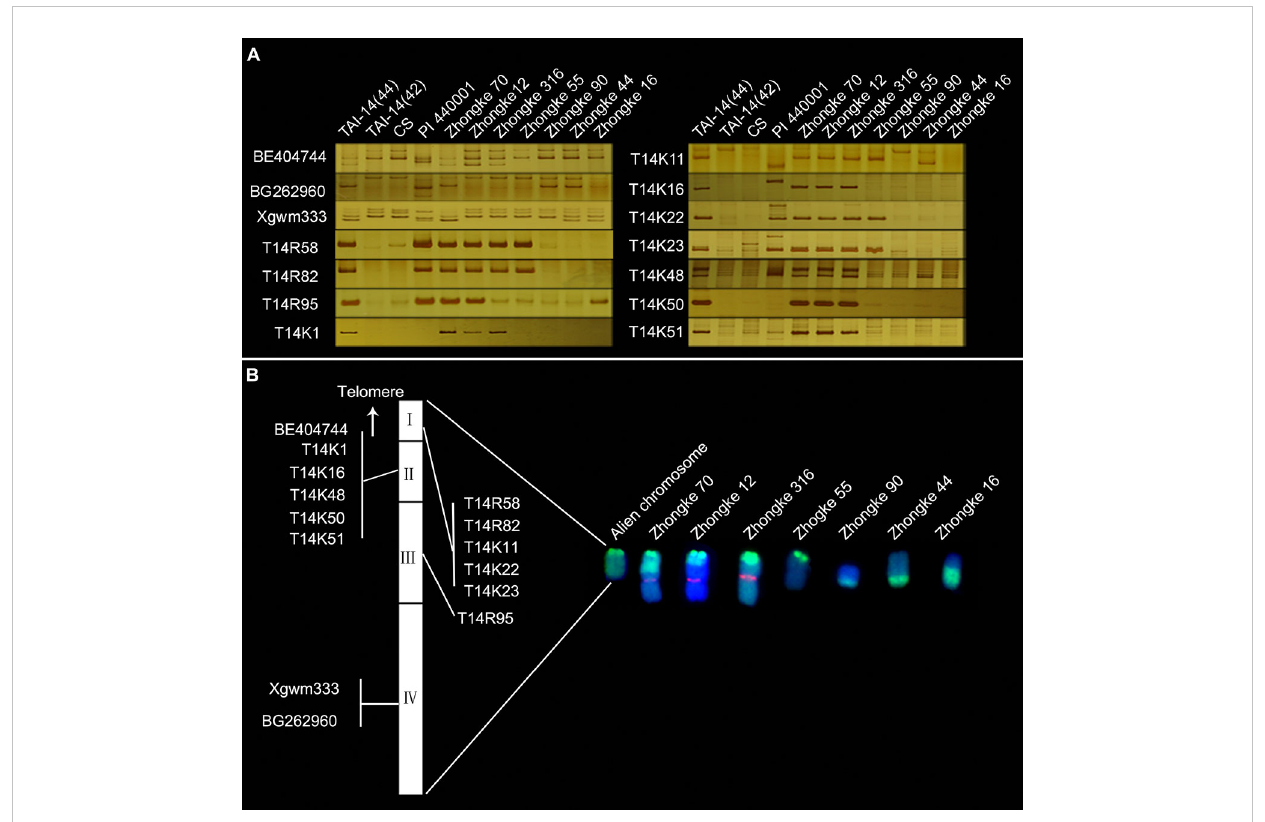
FIGURE 6 Speci fi c markers and a physical map for the alien chromosome. (A) Speci fi c markers for the alien chromosome and their distribution on seven translocation lines with different patterns. Common wheat CS and the Th. intermedium accession PI 440001 were used as control lines for exploiting speci fi c markers for the alien chromosome in TAI-14. (B) Physical map construction for the alien